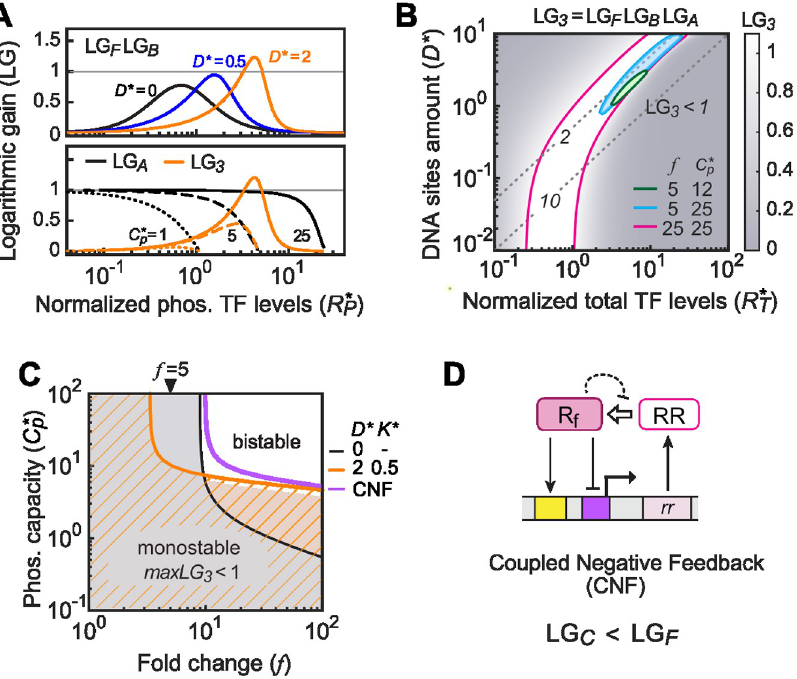
Fig 6. The overall logarithmic gain LG from the three modules determines the monostable parameter range. (A) 3 Overall gains LG 3 are limited by the phosphorylation capacity Cp � . Increased numbers of TFBSs ( D � values: black, 0; blue, 0.5; orange, 2) can elevate the maximal combined LG from the autoregulation ( f = 5) and DNA binding modules ( K � = 0.5) above 1, but also shift the peak LG to higher phosphorylated TF levels (upper panel). This requires a high Cp � value to give a maximal overall LG 3 value above 1 (lower panel). (B) Effect of TFBS abundance D � on the overall LG . Regions bordered by colored lines indicate the parameter space with LG > 1. Dashed lines with numbers indicate 3 3 the TF/TFBS ratio. (C) The parameter space of f and Cp � for monostability determined by maxLG 3 . Solid lines represent lines of maxLG = 1 under indicated conditions or feedback schemes. The gray shaded and orange striped 3 areas indicate corresponding monostable ranges. For simplicity, the value of Ct � is arbitrarily set at 3 for all graphs shown here. (D) A schematic of the coupled negative feedback modeled in (C). The phosphorylated RR can bind to the activation site (yellow) and the repression site (purple) for coupled feedback regulation.